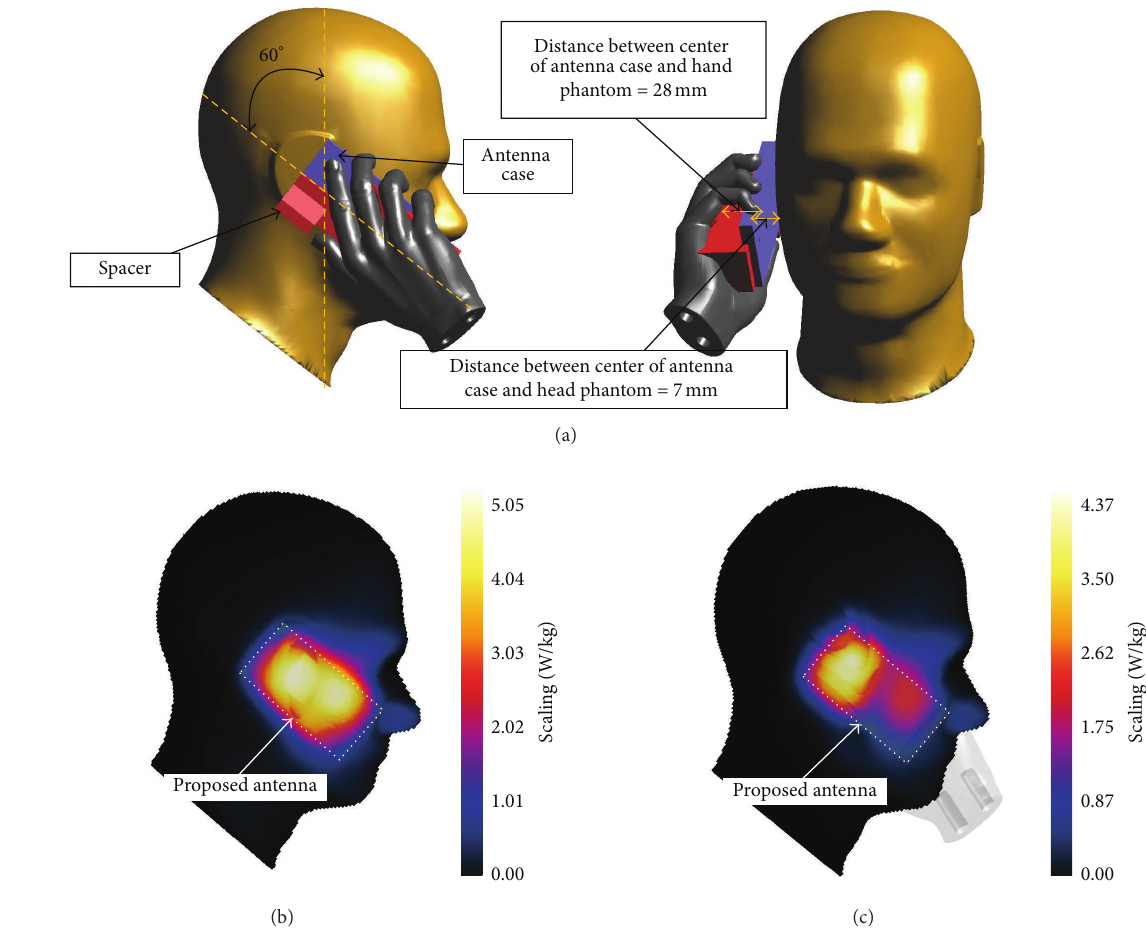
Figure 12: SAR simulation models. (a) Simulation setup. (b) SAR distribution in the head phantom at 1795 MHz. (c) SAR distribution in the head and hand phantoms at 1795